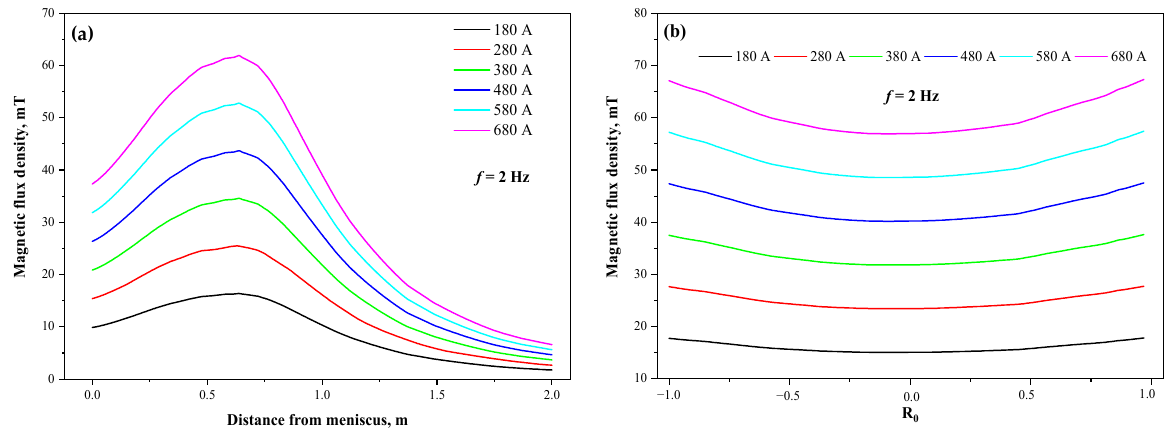
Figure 6. Distribution of magnetic flux density at different current intensities: ( a ) vertical center line; ( b ) horizontal radial line. Figure 7 compares the electromagnetic force at different current intensities in the radial line of the stirrer center, when the section is Φ 650 mm and the current frequency is 2 Hz. The positive or negative values represent the direction of the electromagnetic force. The electromagnetic force increases rapidly with the distance from the center, and the maximum value is located at the edge of the strand. When the current intensity is 180 A, 280 A, 380 A, 480 A, 580 A, and 680 A, the maximum electromagnetic force is 151 N·m − 3 , 367 N·m − 3 , 681 N·m − 3 , 1078 N·m − 3 , 1574 N·m − 3 , and 2163 N·m − 3 , respectively, and the growth rate is gradually accelerating.